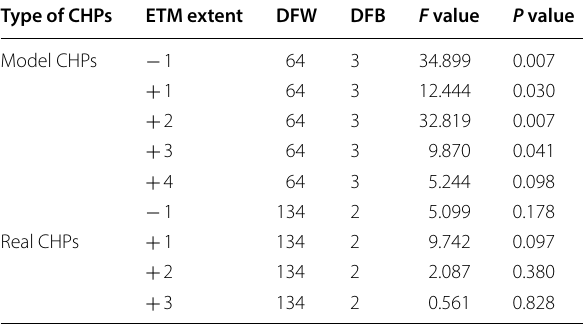
These regression model are shown in Figs. 9 and 10 CHP canopy hemispherical photograph, DFW degree of freedom within groups, DFB degree of freedom between groups